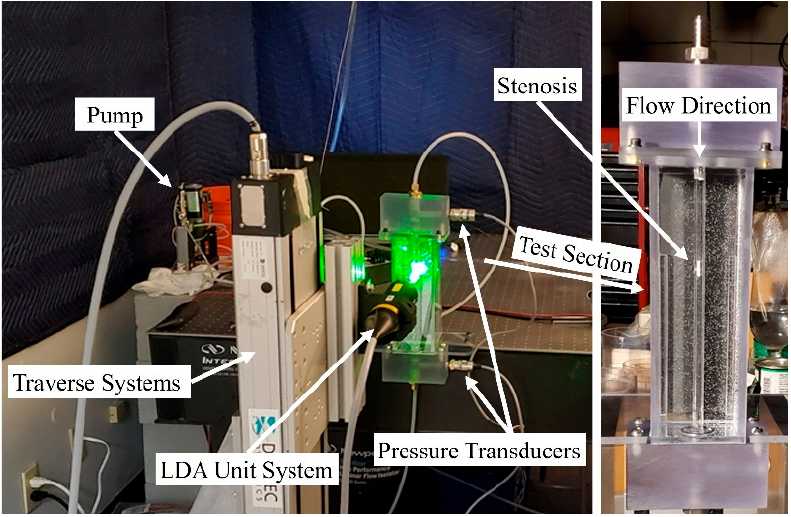
Figure 2. Experimental setup of the Laser Doppler Anemometry (LDA) axial velocity measurements for a constricted pipe representing arterial stenosis.